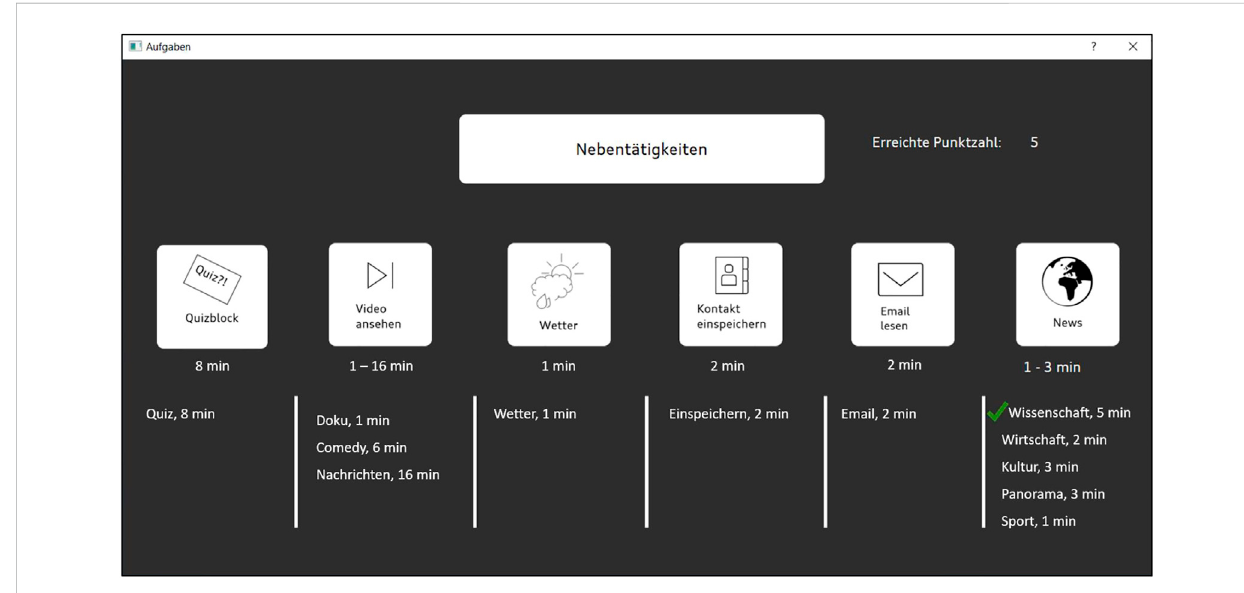
FIGURE 6 Overview screen of the NDRA application.